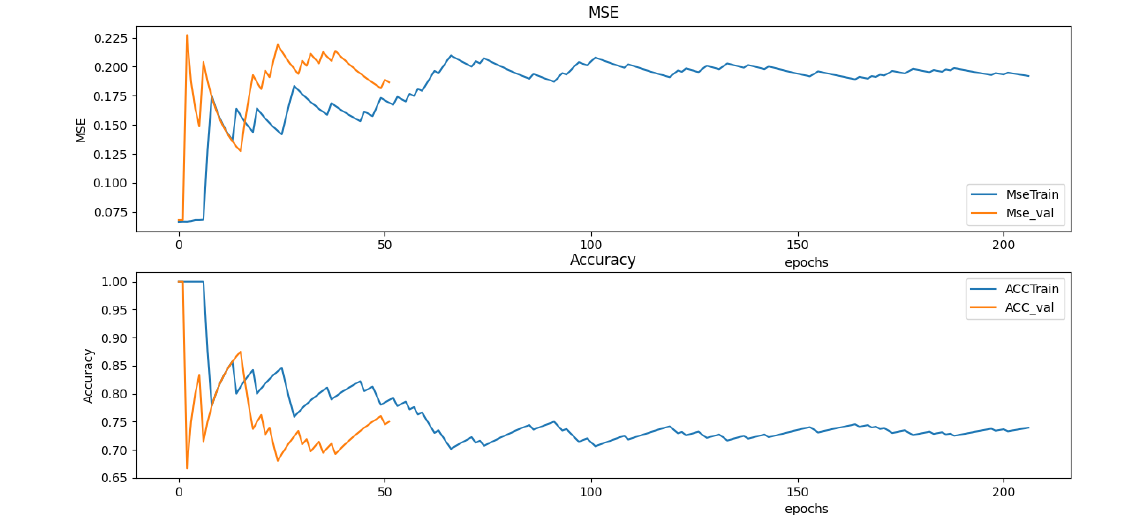
Figure 5. Machine learning algorithm shows increased accuracy and decreased MSE values over the first 50 training rounds (ie, epochs) for predicting MQOL and evaluation skills of HL ( a ccuracy: 0.75, MSE: